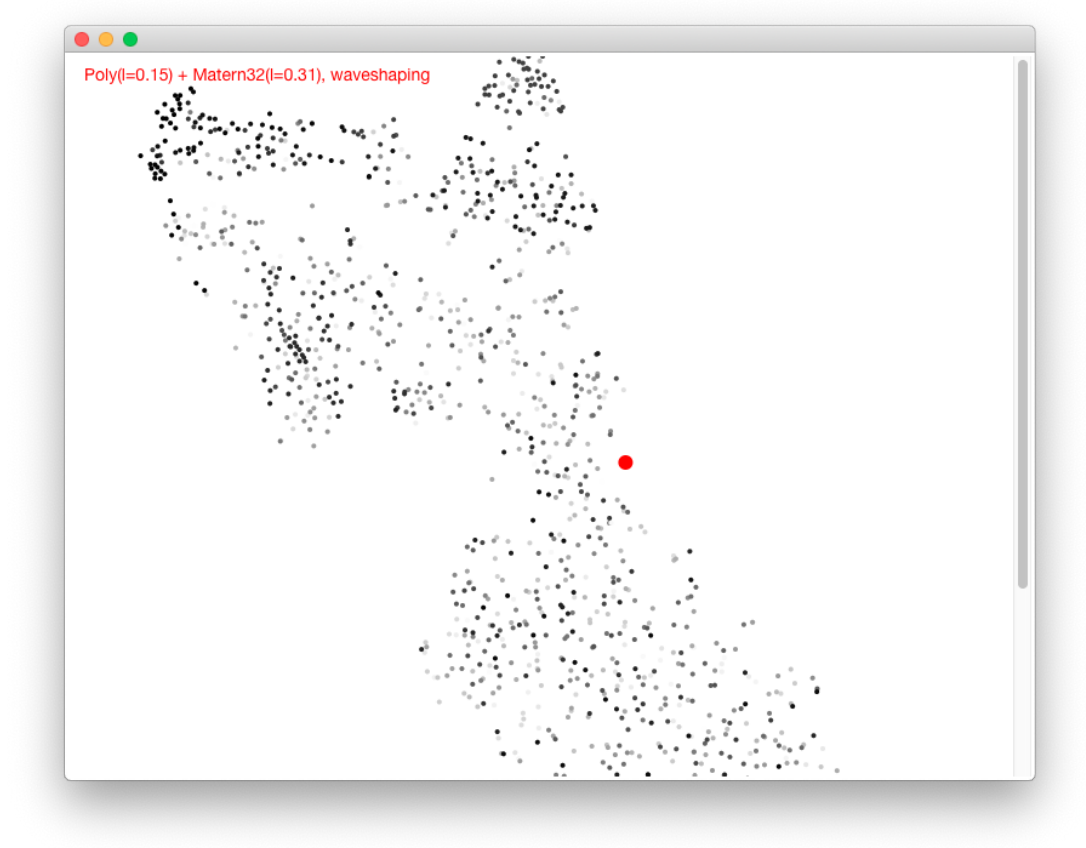
Figure 5. User interface for GP synthesis sound selection. When the user clicks one of the dots, the dot is marked red, and the corresponding sound is played. In the upper-left corner, the parameters of the sound are shown. In this case, the function is drawn from a GP where the kernel is the sum of a polynomial ( (cid:96) = 0.15) and a Matérn 3/2 kernel ( (cid:96) = 0.31 ) . The function is used for